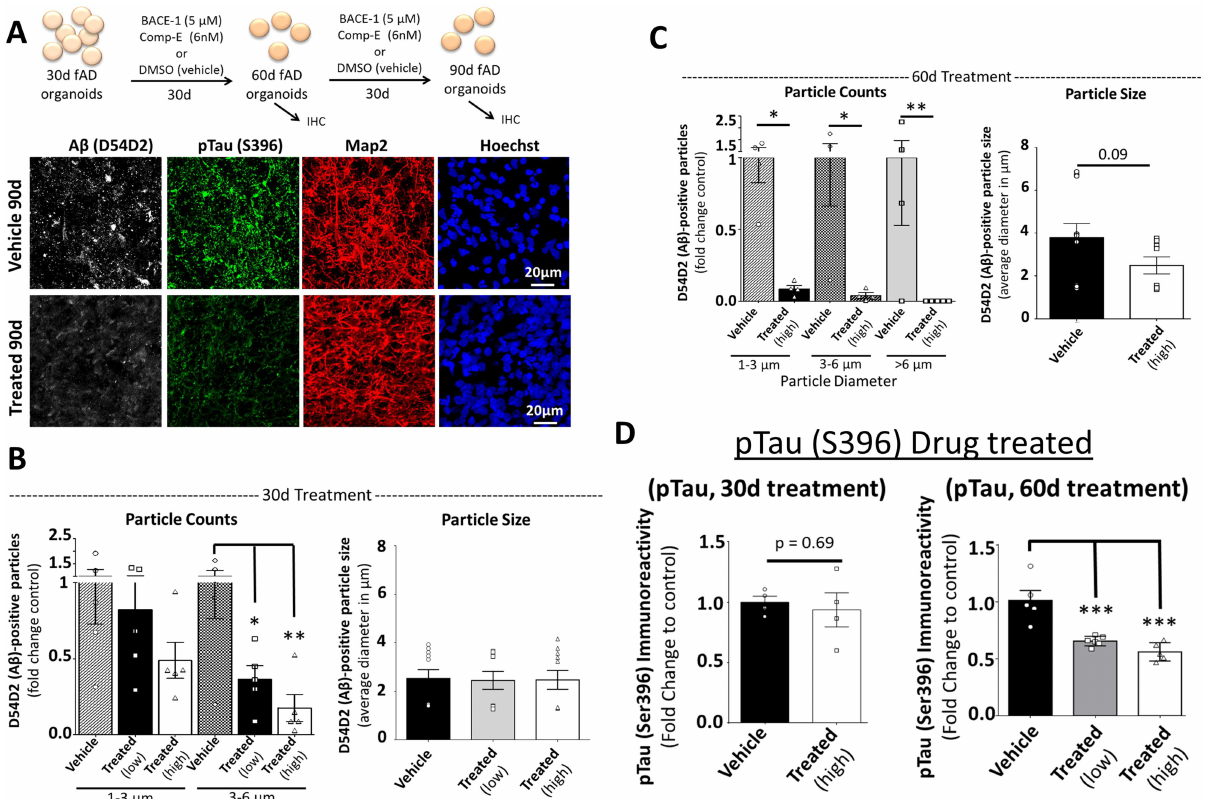
Fig 3. Organoids createdfrom AD patientiPSCs respondto compound treatment. (A) Schematic of beta (BACE-1) and gamma (Comp-E)secretase inhibitortreatment(top).At 30 days of culture,fAD ( APP Dp 1-1)organoidswere treatedwith low dose (BACE-1, 1 μ M and Comp-E,3nM)or high dose (BACE-1, 5 μ M and Comp-E6nM) combined compounds, or equivalent DMSO vehicle. Following 30 or 60 days of cultureand drugtreatment,organoidsat 60 and 90 days of culture,respectively, were processedfor immunohistochemistry(IHC). Tissue sectionsfromfAD ( APP Dp 1-1)and control(Ctrl;CS-0020-01) organoidswere processedfor immunoreactivityagainstA β (D45D2, white),pTau (Ser396,green),and MAP2 (red).Examineimagesare from90 day organoids.(B) Quantification of A β particlenumberand size in compound treatedand fAD organoidsfollowing 30 days of administration. Numberof A β -positive aggregates in two size classes (ParticleCounts):one-way ANOVA with FishersLSD test for multiplecomparisons; F (5,24)= 3.58, * p = 0.014,R 2 = 0.4296.Particle size: one-way ANOVA with Kruskal-Wallis test for non-normaldistribution ( α < 0.05),p = 0.475.(C) Quantification of A β particlenumberand size in treated(highdose) and untreatedfAD organoids following 60 days of compound administration.Numberof A β -positive aggregates in threesize classes (ParticleCounts):one-way ANOVA with Fishers LSD test for multiplecomparisons; F (5,19)= 5.02, ** p = 0.004,R 2 = 0.5691.Particlesize: Mann-Whitney two-tailedtest for non-normaldistribution ( α < 0.05),p = 0.09.(D) Quantification of the average intensityof pTau Ser396immunoreactivity as a fold change of Ctrlin fAD organoids following 30 and 60 days of compound treatment.30 day treatment.(Each data point representone organoid). Unpaired two-tailedt-testwith equal variance, p = 0.69. 60 day treatment:one- way ANOVA with Tukey’s multiplecomparisons test,F (2,13)= 19.82, *** p = 0.0001,R 2 = 0.7530.On charts: * p < 0.05, ** p < 0.01, *** p <